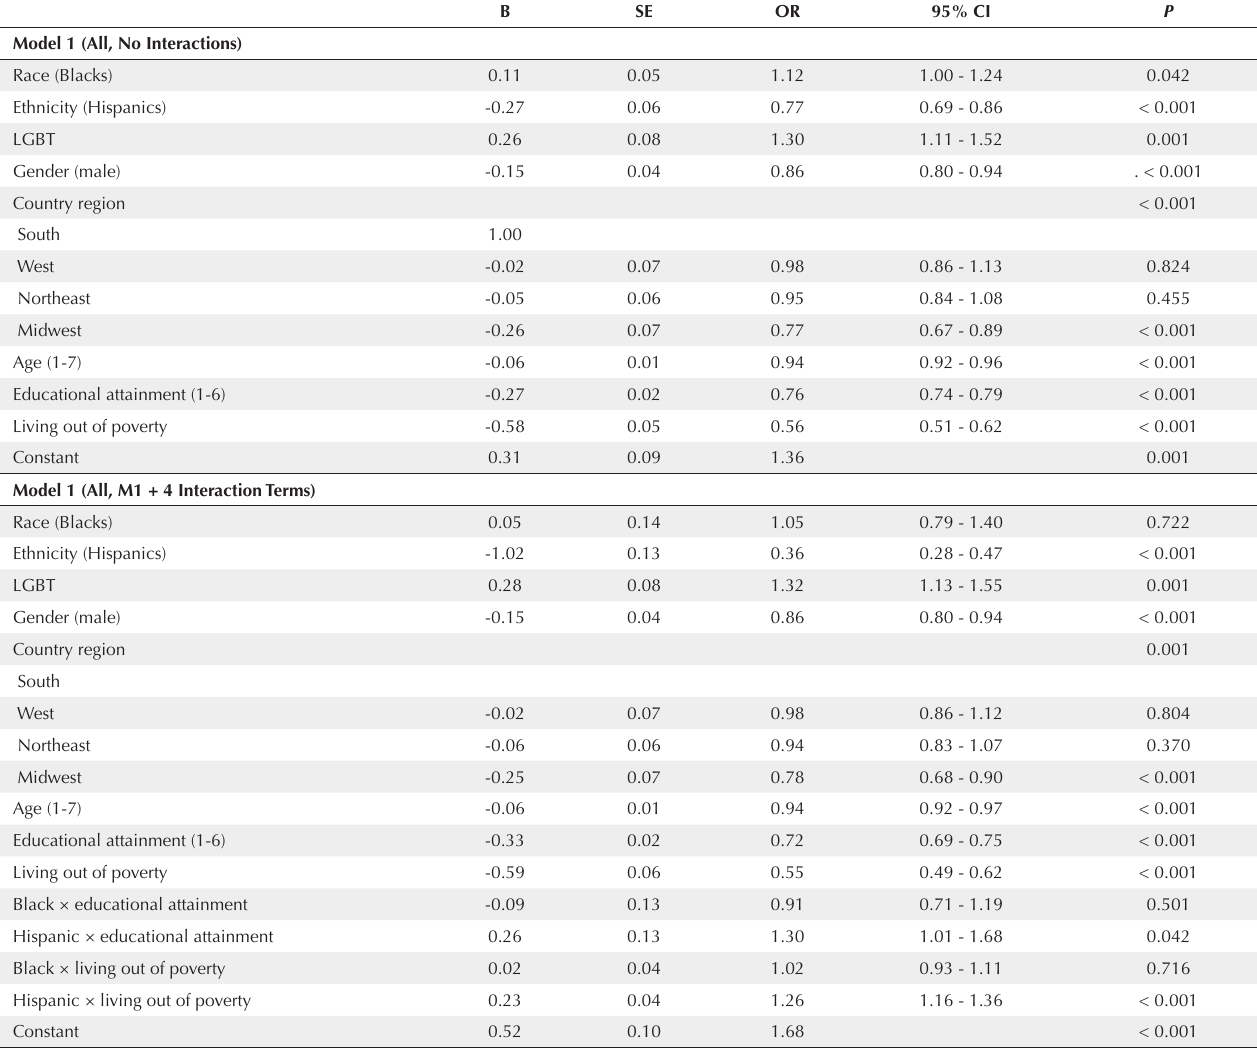
Table 3. Summary of Logistic